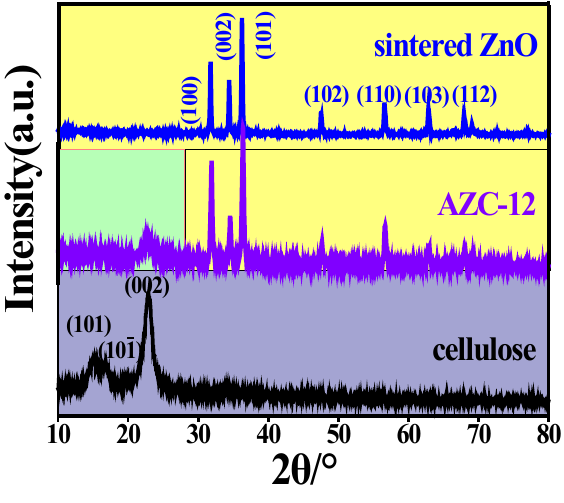
Figure 1: XRD plots of cellulose, sintered ZnO and